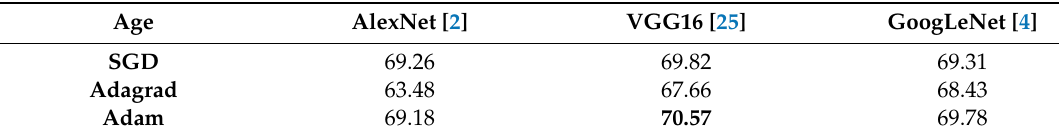
Table 3. Age classification results of the CIA database by the three CNNs.